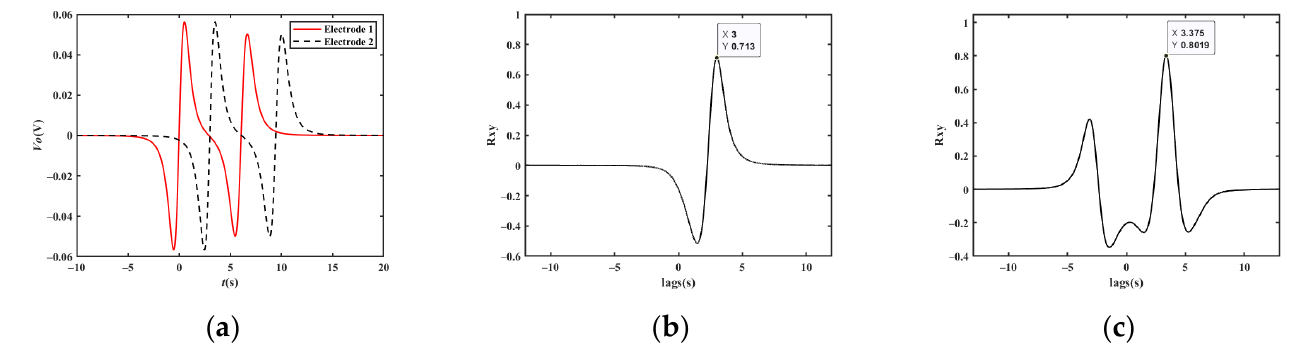
Figure 14. Diagram of vehicles driving close together.